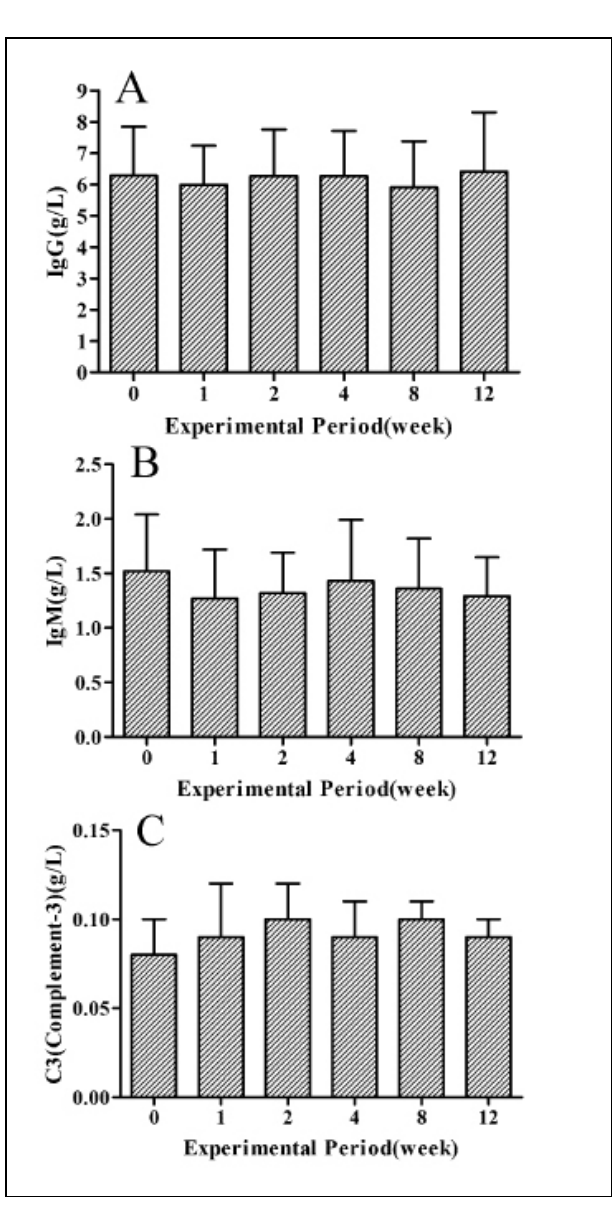
Fig. 5 - Immunological indexes at pre- and 1, 2, 4, 8 and 12 weeks after implantation. Panels A-C show changes of levels of C3, IgG and IgM, respectively.